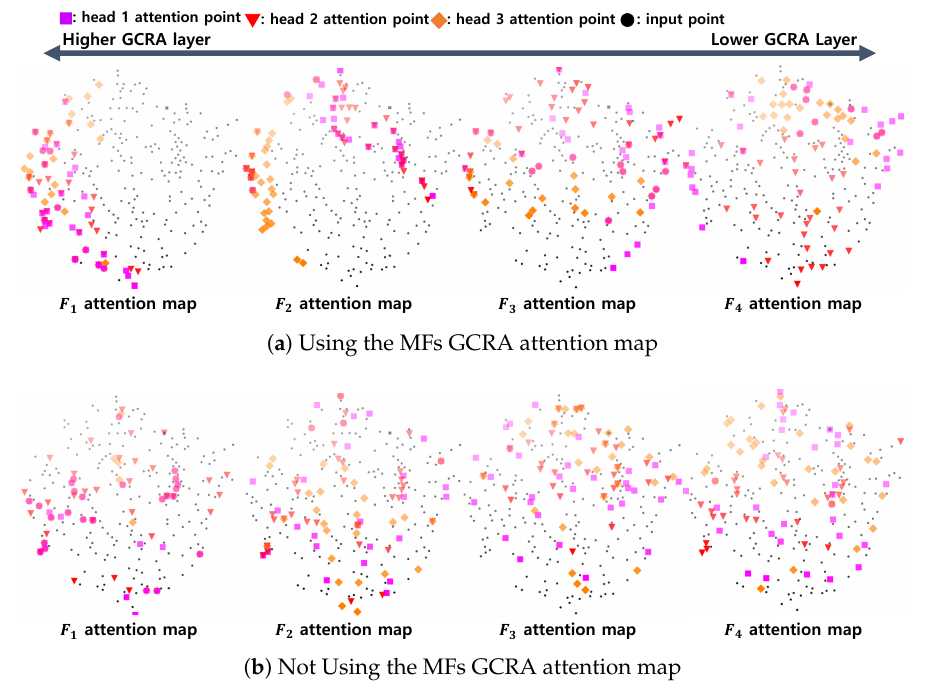
Figure 9. Visualization of attention map generated using MFs as a query in GCR with H = 4.